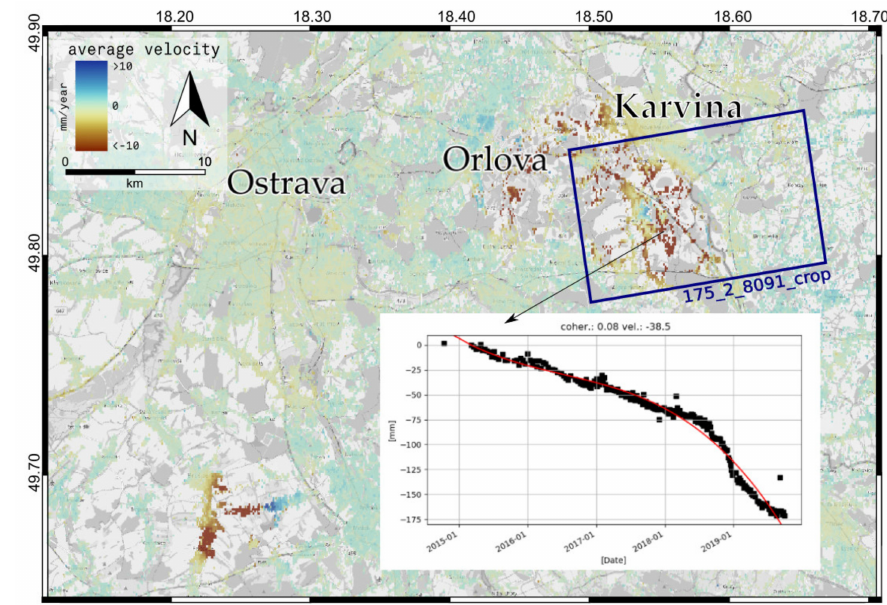
Figure 5. Example of a time series of a selected PS point, visualised using giSAR Quantum GIS toolbox. The area marked as 175_2_8091_crop defines a reprocessed crop of interest described in Section